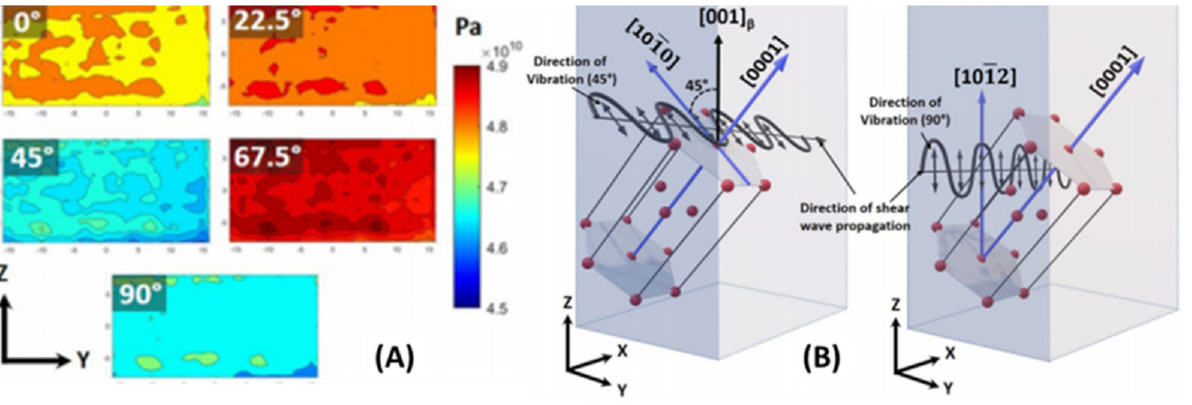
Figure 21. ( A ) Ultrasound scanned angle-dependent dynamic Young’s modulus distribution. ( B ) Hypothesis based on the experimental observation from ultrasonic techniques and conventional